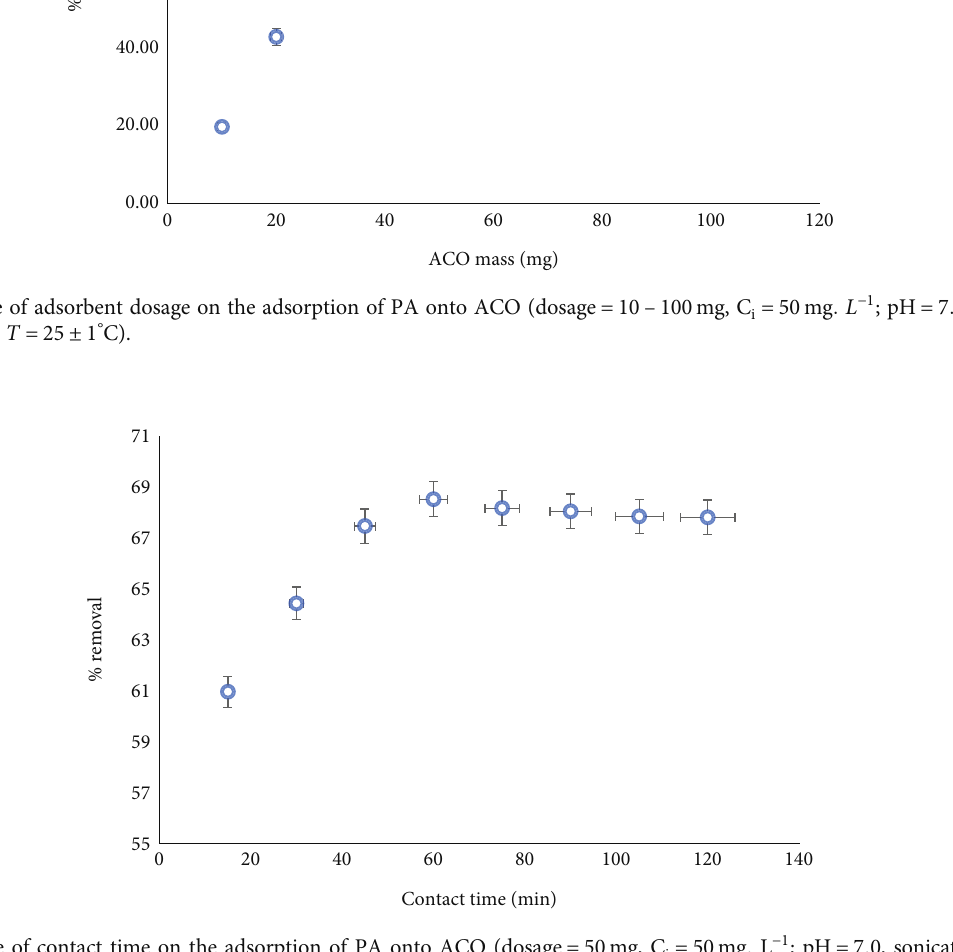
= 50 mg : L − 1 ; pH = 7 : 0 , sonication time = 15 i